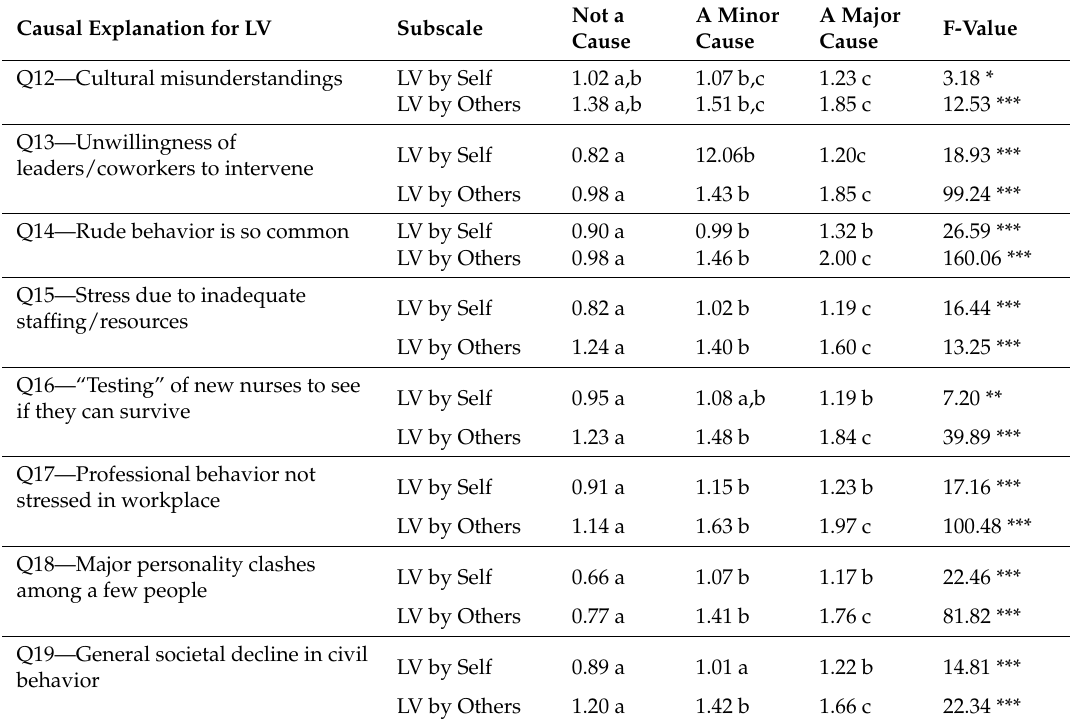
Table 5. Mean scores on the Prevalence/Severity of LV Subscales as a Function of Endorsement of Causal Explanation of